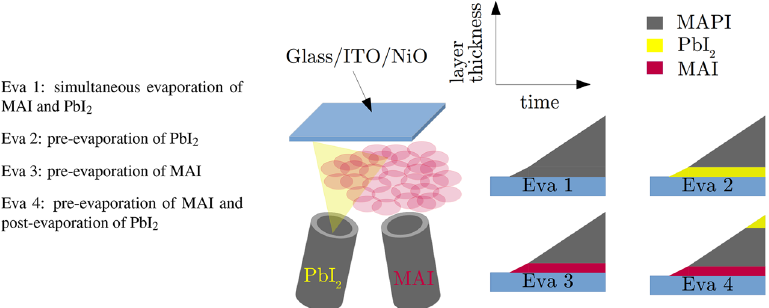
Figure 1. Schematic representation of the co-evaporation schemes using PbI 2 and MAI precursors on glass/ITO/NiO substrates to grow MAPI. While PbI 2 evaporates as a molecular stream, MAI is distributed homogeneously in the chamber, increasing the total chamber pressure 13,14 . Different evaporation schemes